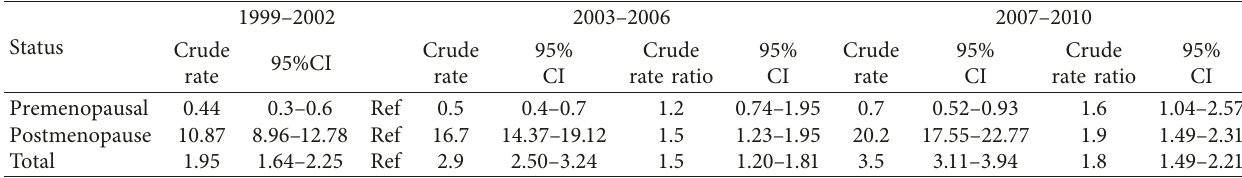
Table 3: The crude rate of uterine cancer in Gharbiah province for pre- and postmenopausal women with rate ratio (total n � 660),